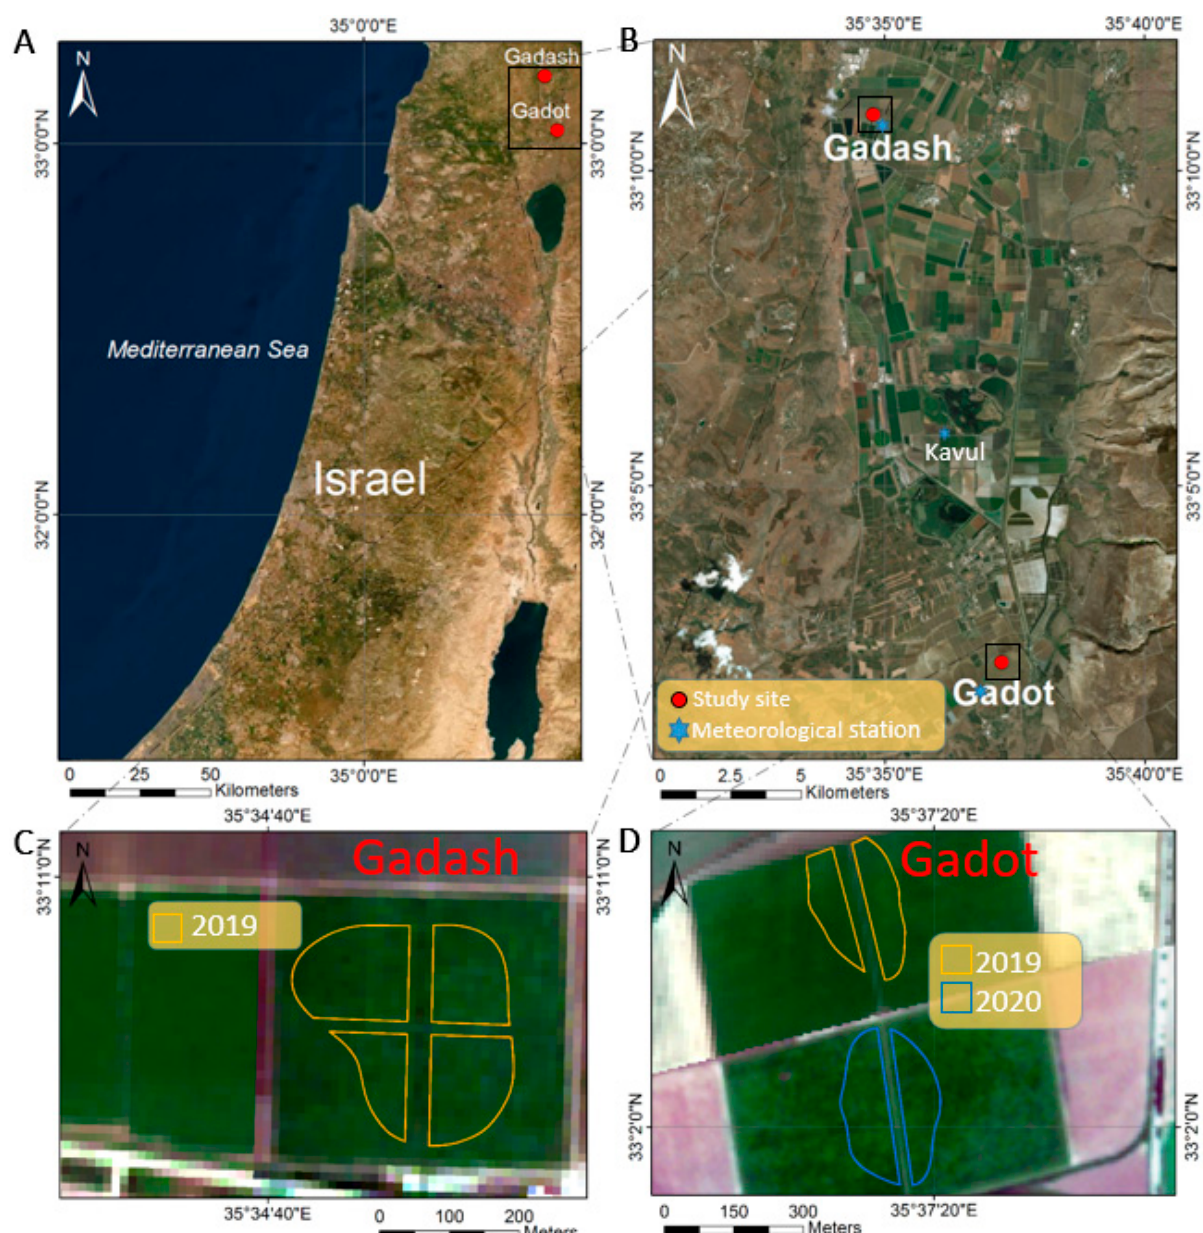
Figure 1. The locations of experimental plots: ( A ) Map of Northern Israel; ( B ) Map of the Hula Valley; ( C ) Gadash; ( D ) Gadot. The fragmented shape of the analysis polygons results from excluding unvegetated paths in the fields. Sources of the basemaps: Esri, Sentinel-2, VENµS.